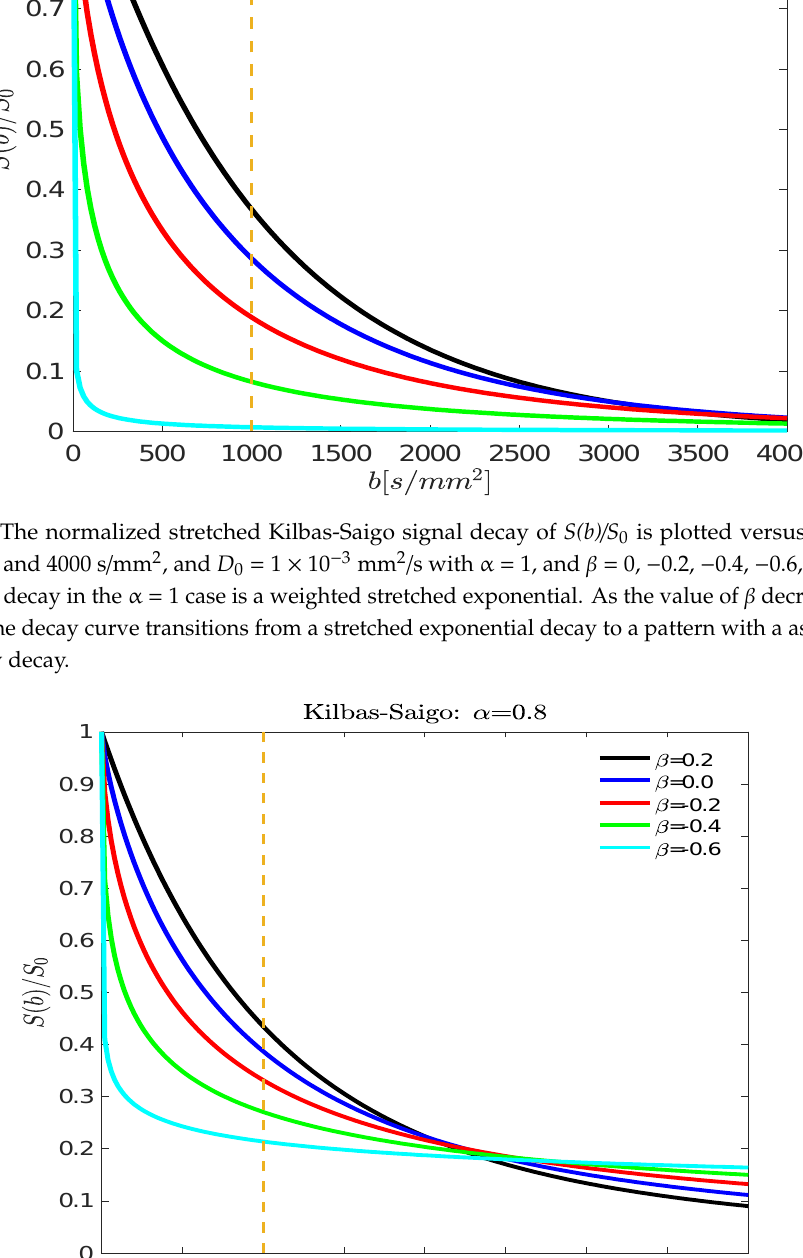
Figure 7. The normalized stretched Kilbas-Saigo signal decay of S(b)/S 0 is plotted versus b -values between 0 and 4000 s/mm 2 , and D 0 = 1 × 10 − 3 mm 2 /s with β = 0.2, and α = 0.2, 0.4, 0.6, 0.8, and 1.0. In the figure, we see for a fixed power law decay of D(b) the shift from lower to higher decay rates as α approaches the exponential function. 3.2. Fitting Fractional Order D(b) Models to DW-MRI Data